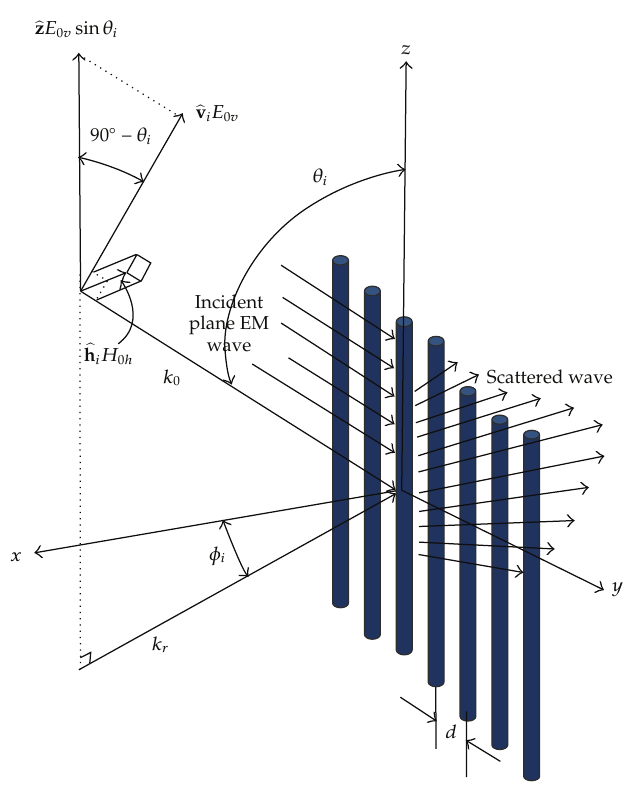
Figure 1: The schematic of the scattering by an infinite grating at oblique